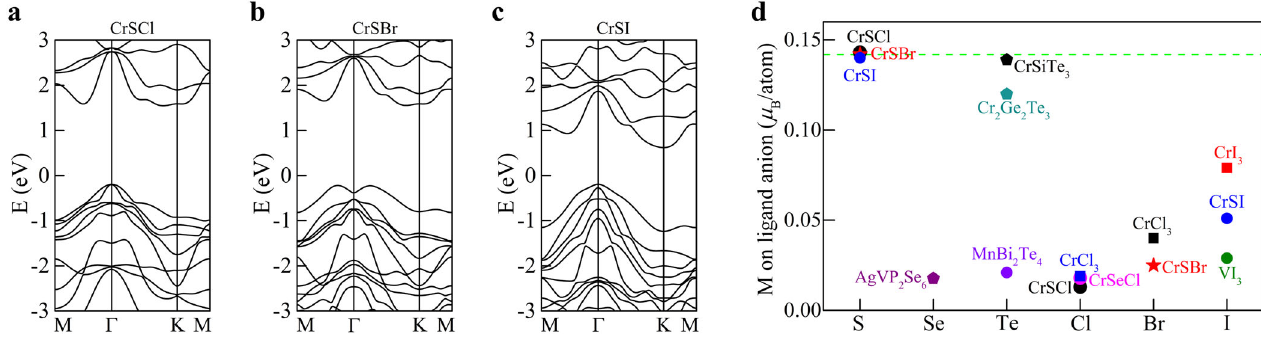
Fig. 2 DFT + U + SOC calculated band structures. a CrSCl, b CrSBr and c CrSI. d A summary of the DFT calculated induced magnetic moments ( M ) on the ligand anions of CrSX and other eight representative FM semiconductors. The value of M on S 2 − ion in CrSBr is highlighted by the green dashed line.